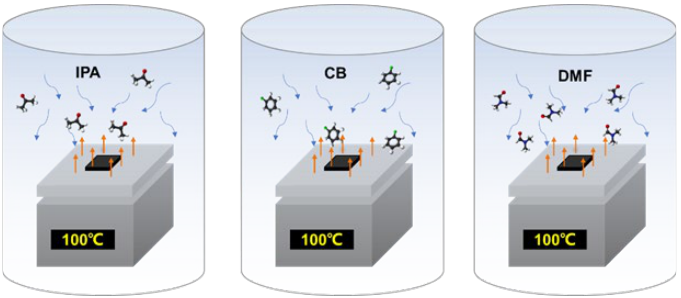
Figure 1. Schematic illustration of the atmosphere-controlled apparatus during perovskite film an- nealing.